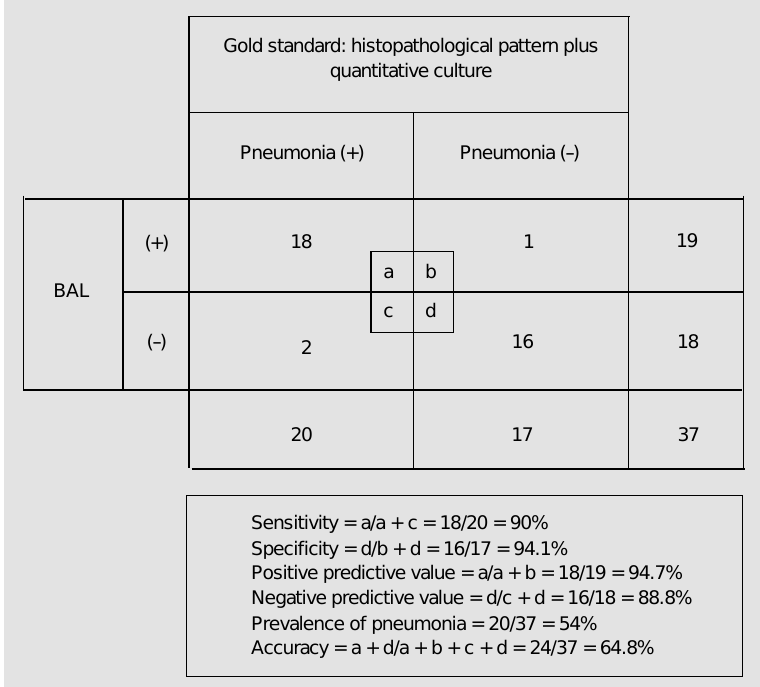
Figure 1. Summary of data concerning validation of bronchoalveolar lavage (BAL) results as a diagnostic test for pneumonia. The gold standard parameters were open lung biopsy histopathological pattern for pneumonia plus quantitative culture of lung